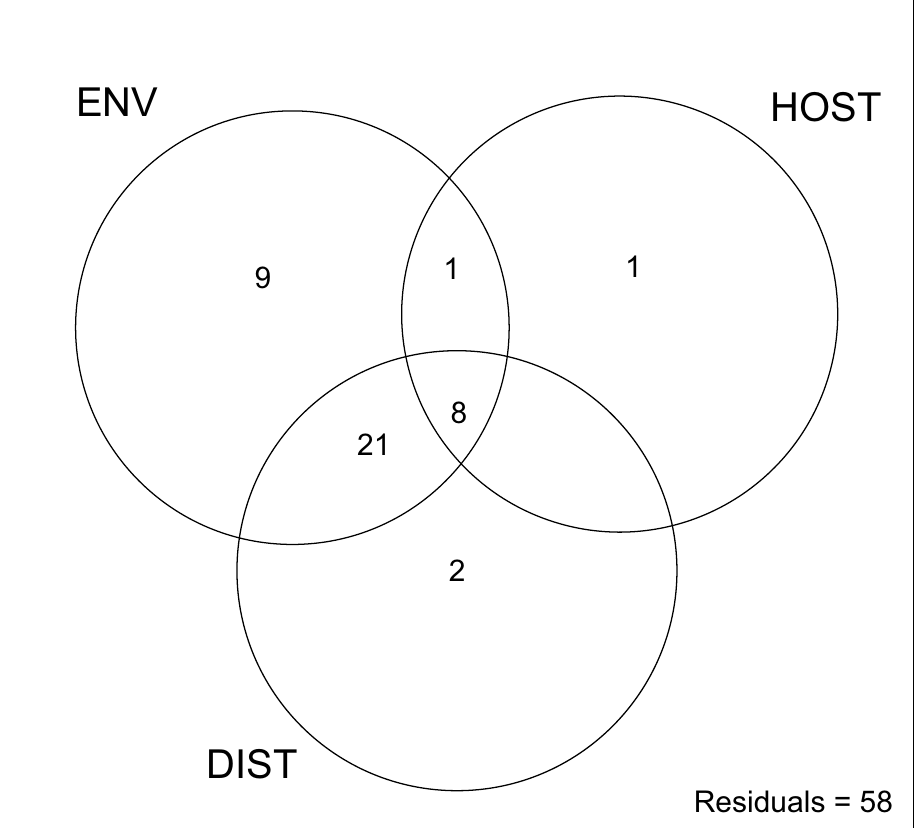
Fig 5. The proportion (%) of m ā nuka phyllosphere microbiome variation explained by environmental, spatial, and host tree variables. Results of partial regression analysis show the proportion of variation attributable to each individual and combination of explanatory variables. Environmental variables (ENV) represent the night-day temperature differential, night temperature, monthly precipitation, and monthly cloud cover. Spatial variable (DIST) represents the straight-line distance between sample coordinates. Host tree variables (HOST) represent tree height and tree diameter.